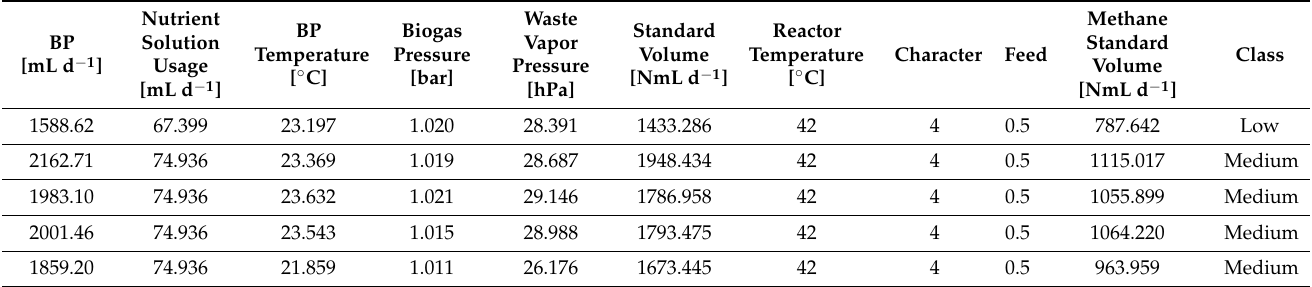
Table 1. The first five cells of the dataset after dropping the unnecessary